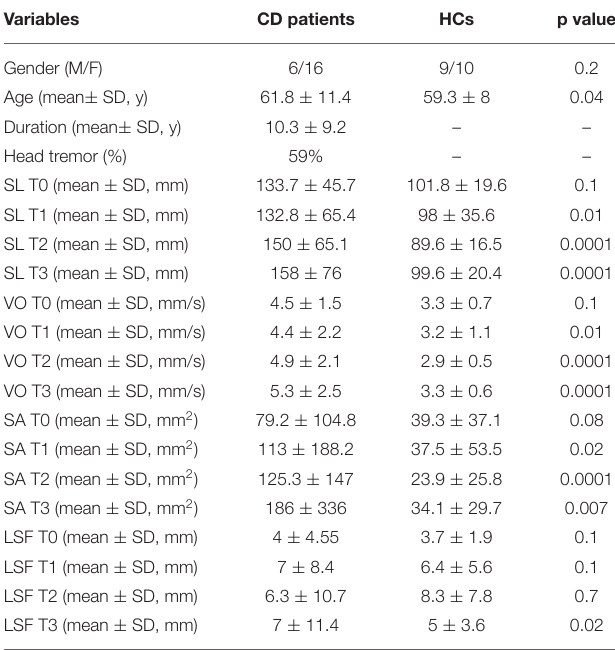
TABLE 1 | Demographic, clinical and stabilometric data in CD patients and in